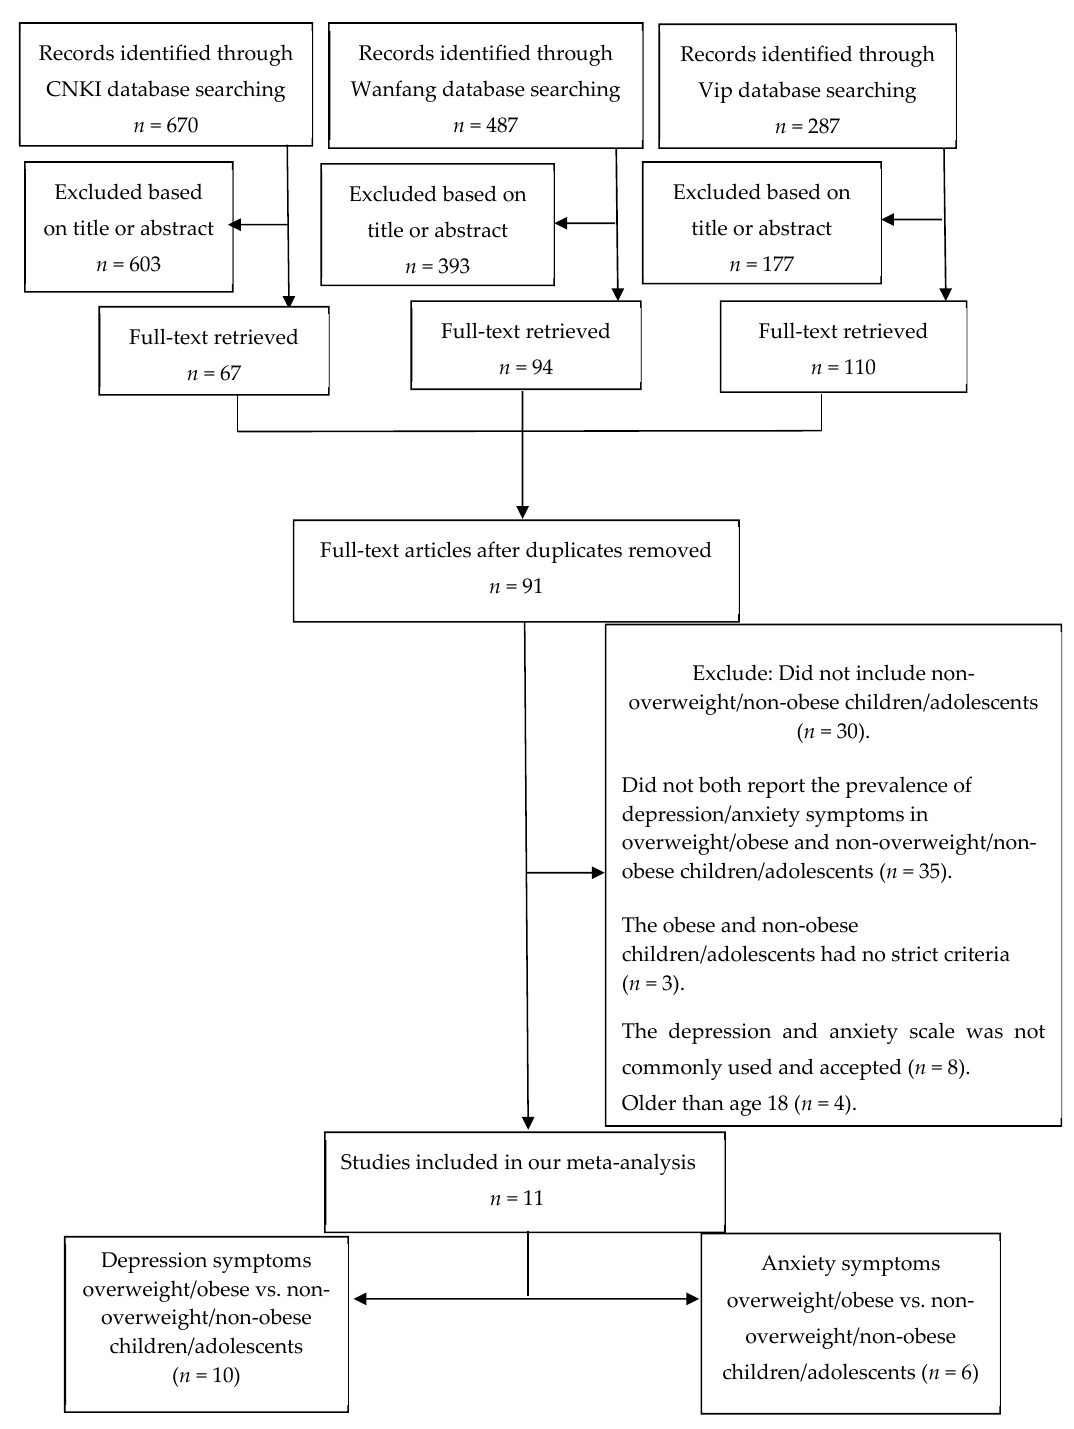
Figure 1. The selection process of the study.